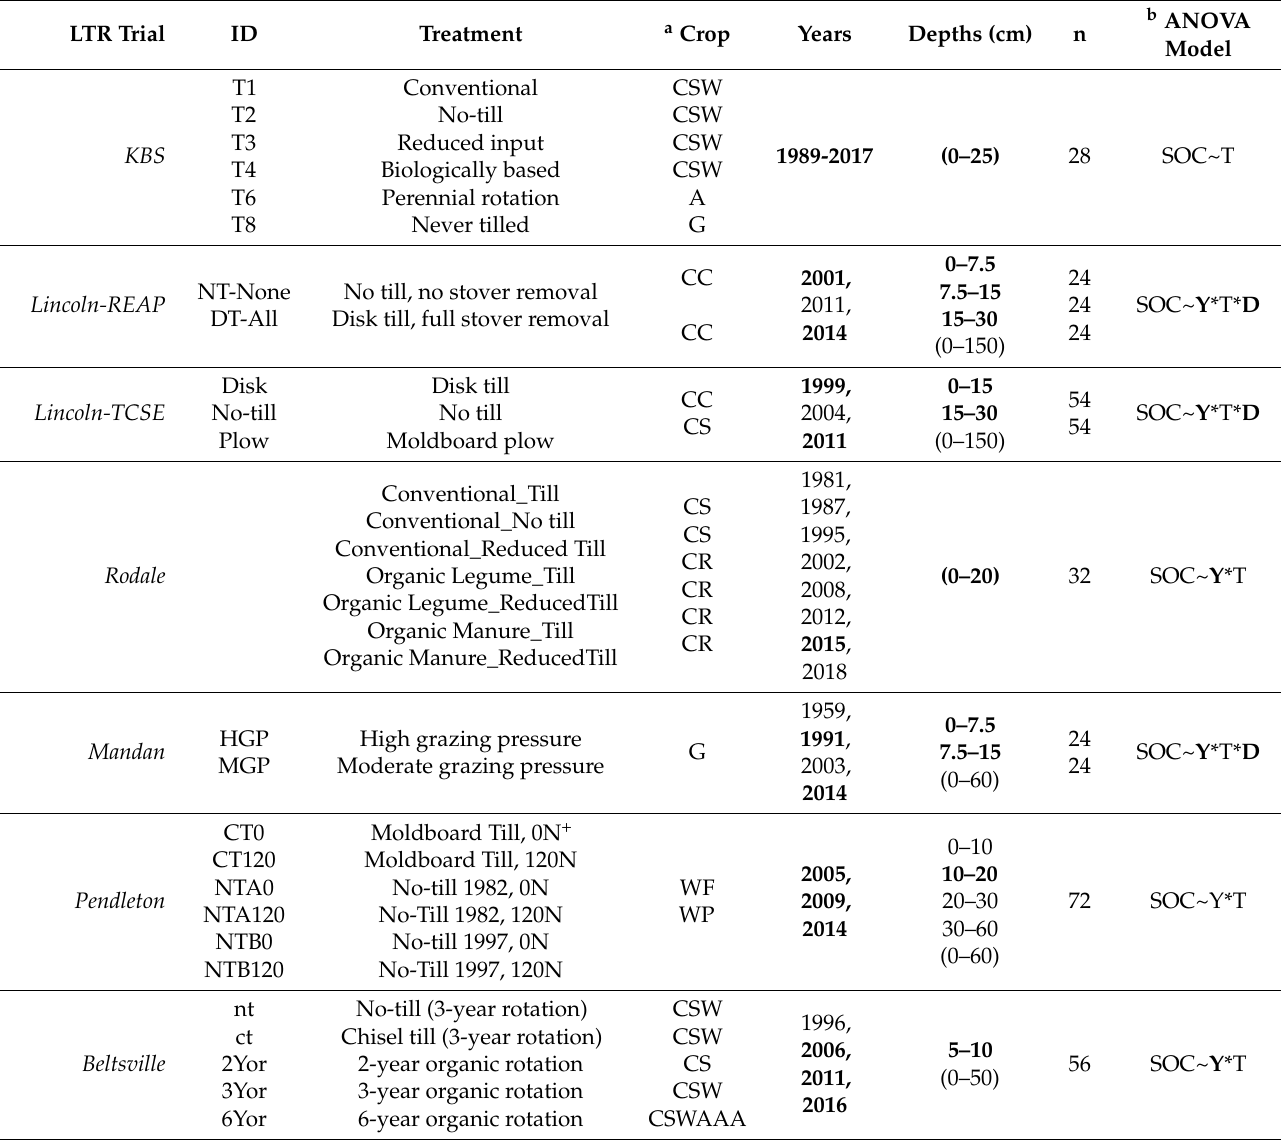
Table 1. Trial and ANOVA model